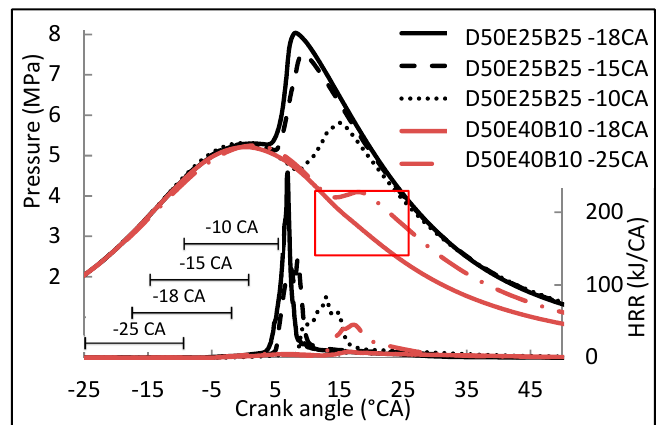
Figure 11. In-cylinder pressure and HRR graph of D50E25B25 and D50E40B10 blends against a crank angle by using different injection times.